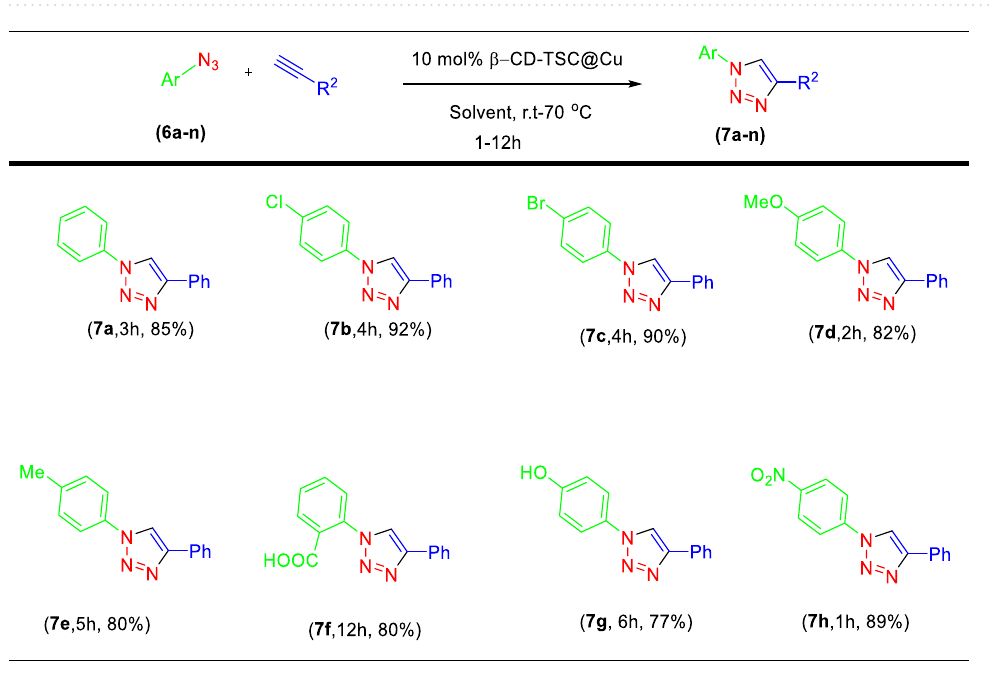
Table 3. Azidation of arylamines.